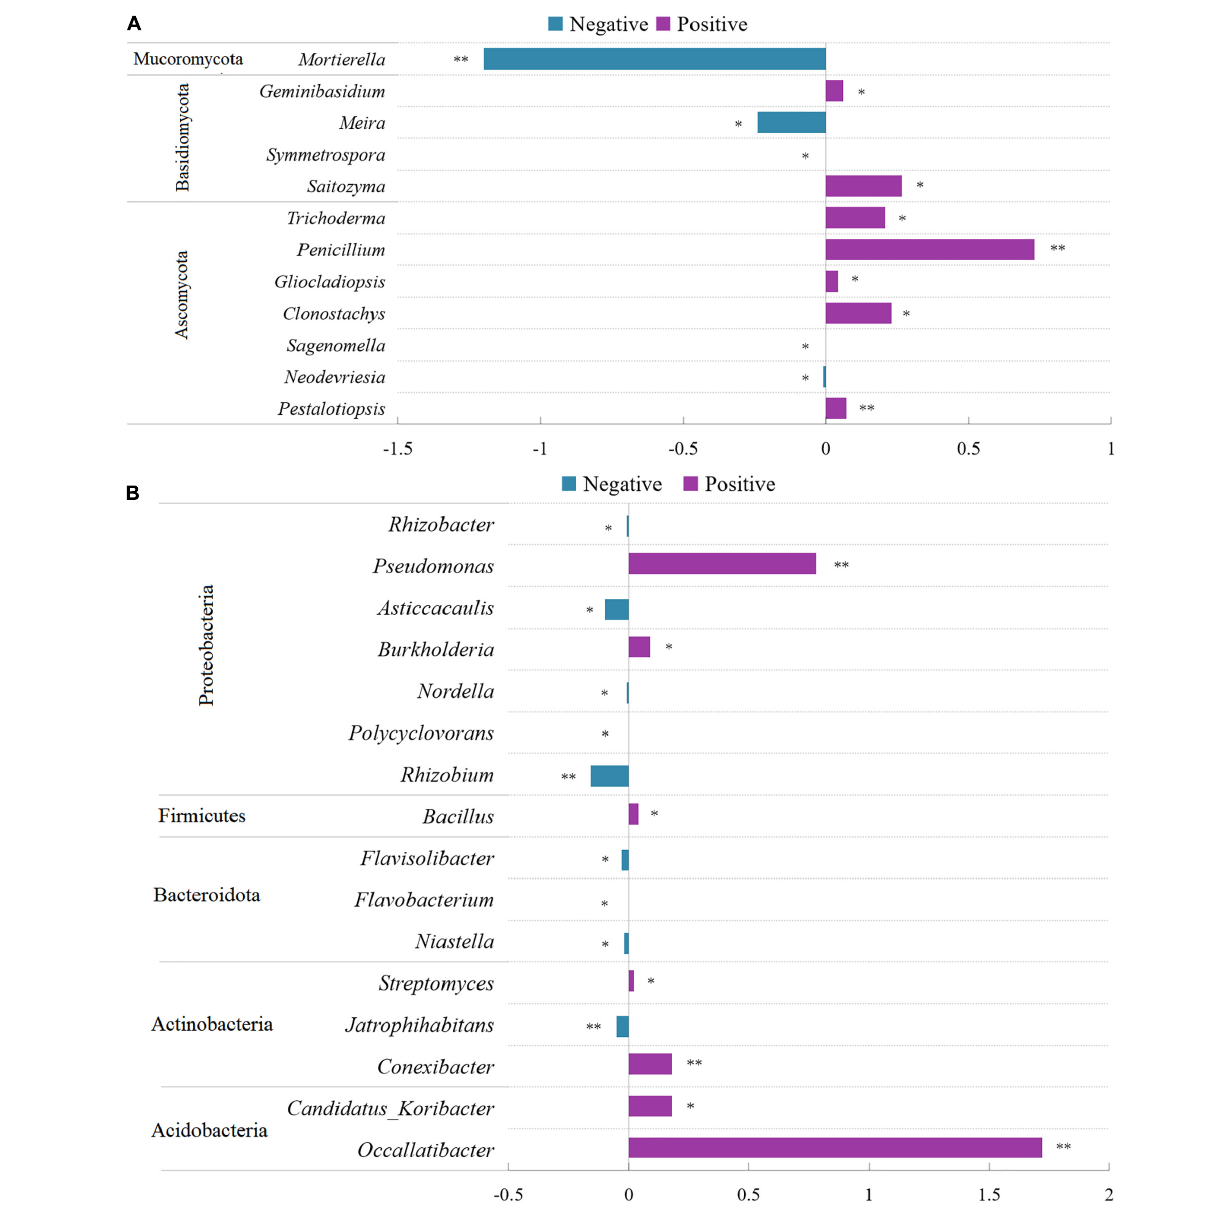
Frontiers in Microbiology |